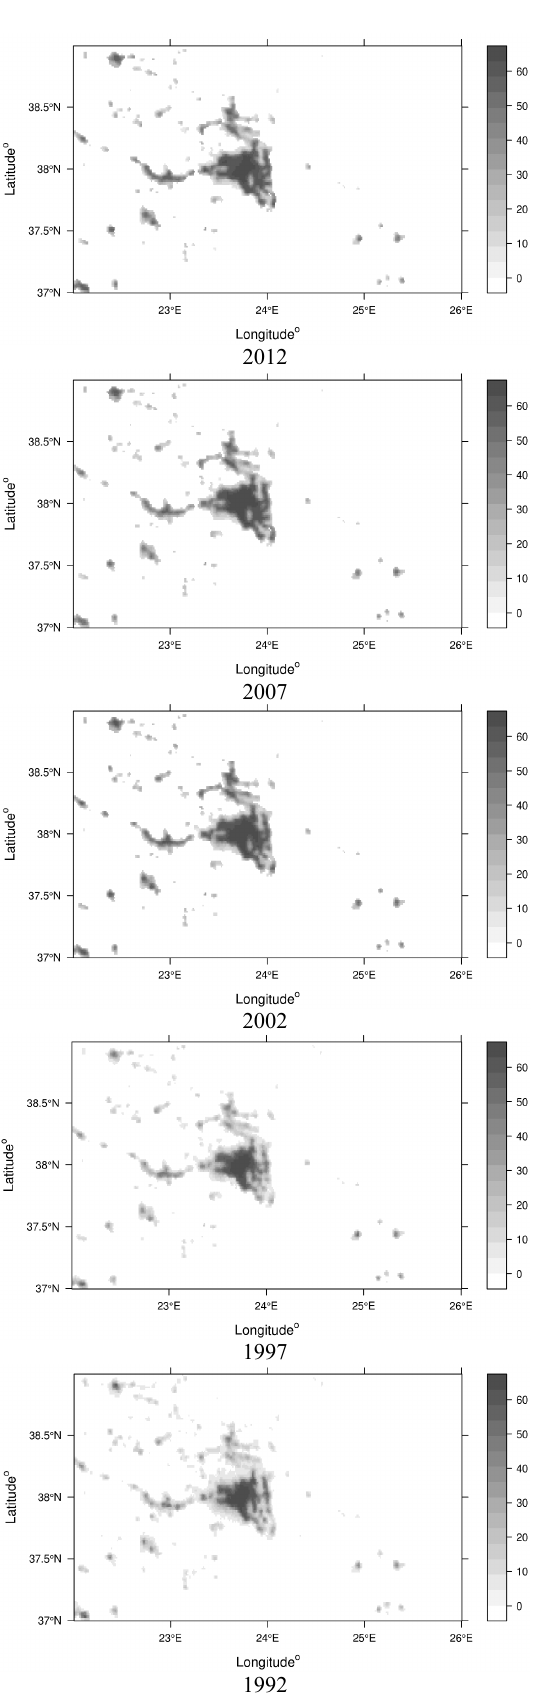
Figure 2. Time series of night lights for Sicily (left) and Athens